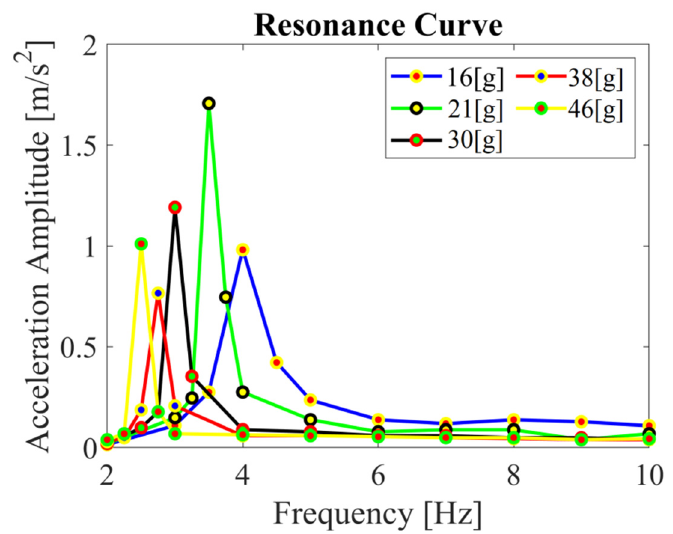
Figure 7. Acceleration amplitude as a function of excitation frequency (FFT analysis) for the considered bluff body masses for the case without airflow.